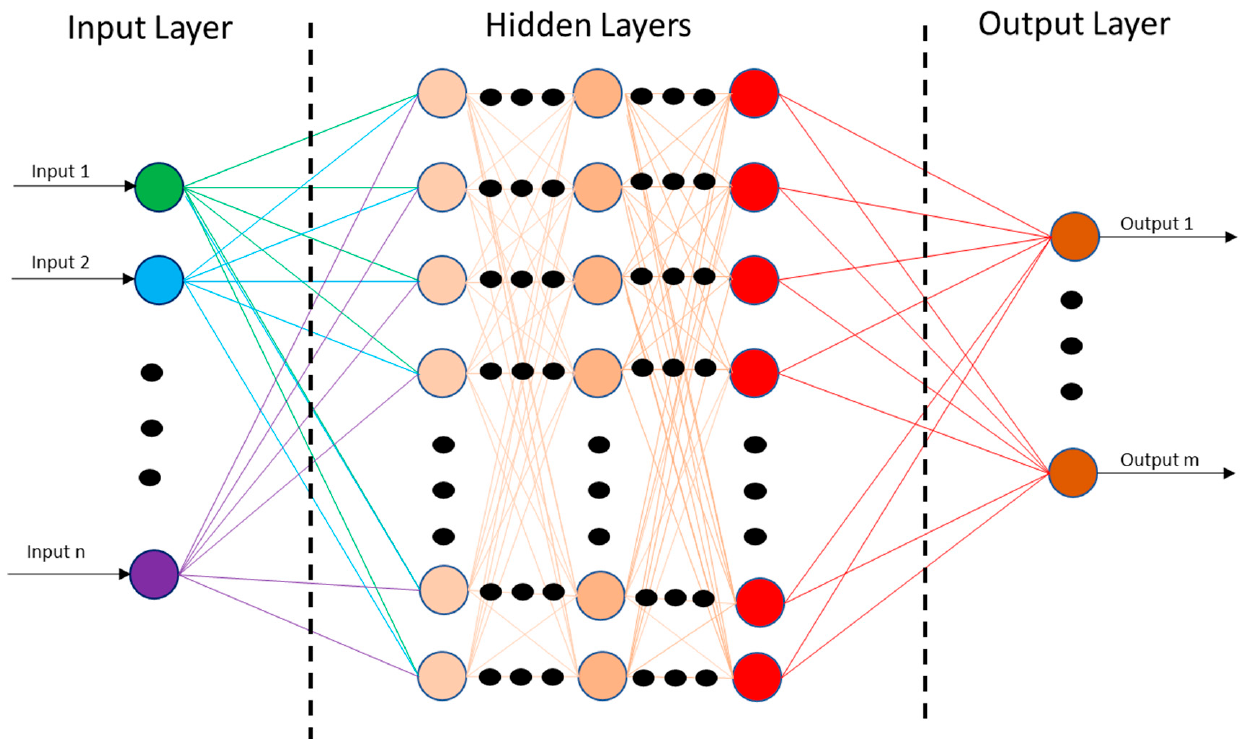
Figure 1. Schematic representation of an MLP. The first layer represents the information given by the 6 SHs (each one needs 344 neurons, as it is the number of slopes given). Finally, the output layer consists of 150 neurons, each one for each Zernike coefficient given. Obviously, all the neurons of each layer are interconnected with those of the next and previous layers.